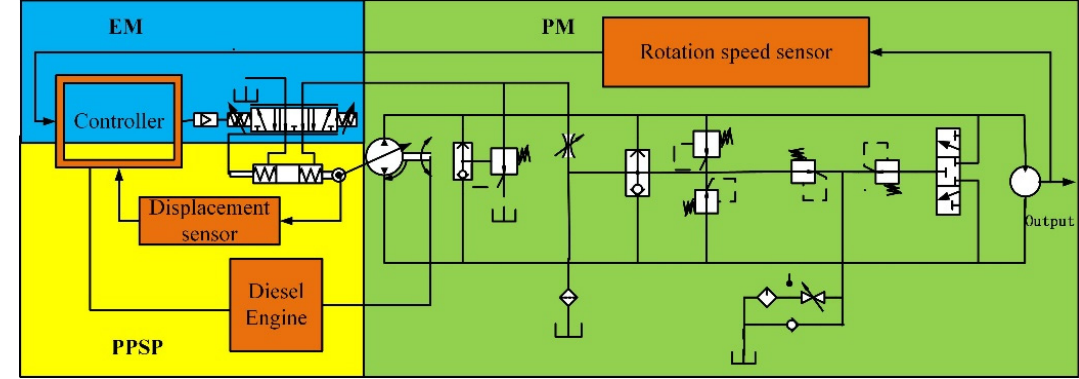
Figure 2. Working principle diagram of variable pump control fixed motor.